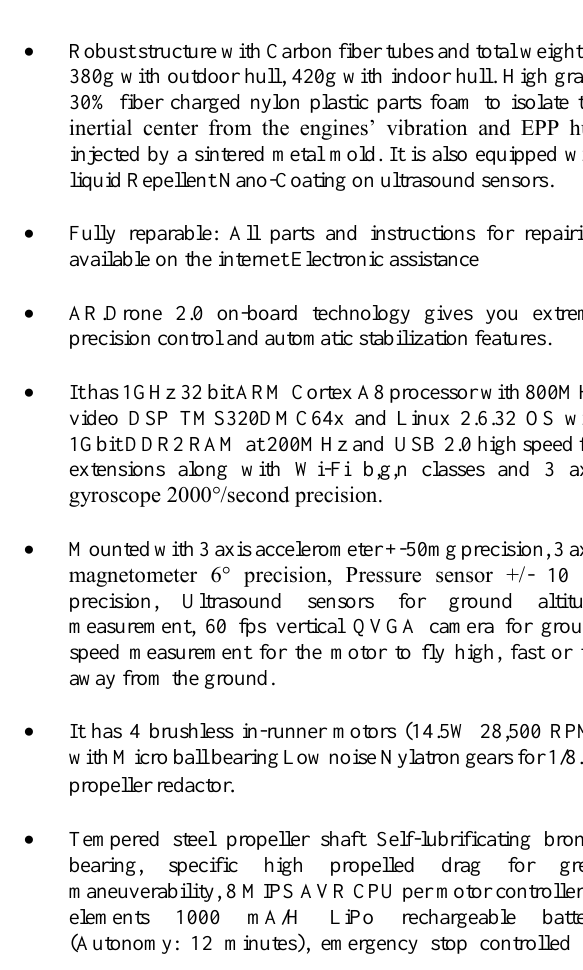
Figure 2. The result of AgiSoft PhotoScan software using 500 images extracted from the move made by Ar. Drone 2 in PSX AgiSoft